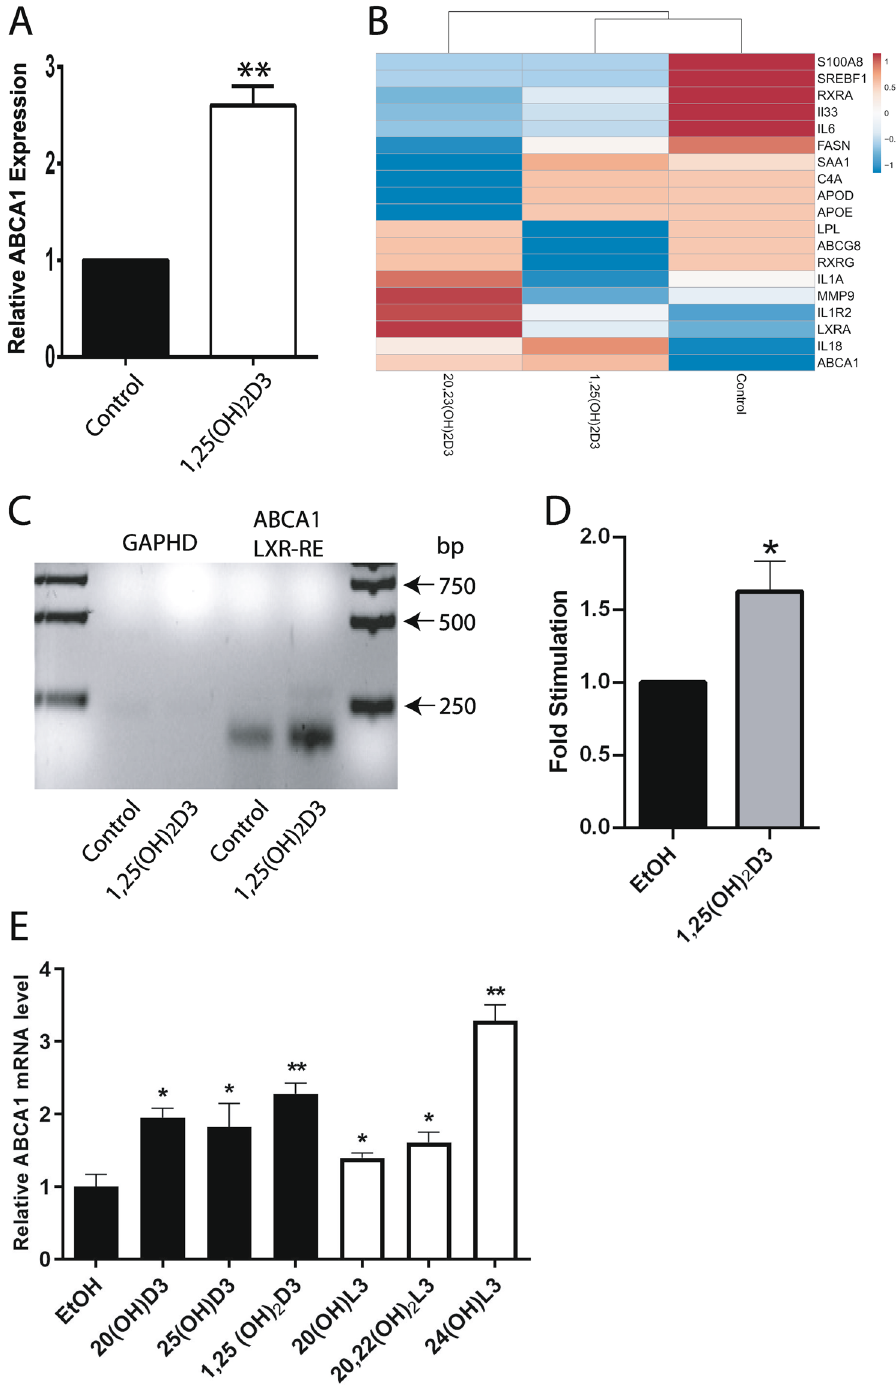
Figure 1. 1,25(OH) 2 D3 and CYP11A1-derived secosteroids stimulate LXR activated ABCA1 gene expression in HaCaT keratinocytes. Relative expression of ABCA1 gene after treatment with 10 –7 M 1,25(OH) 2 D3 and 20,23(OH) 2 D3 for 6 ( A ) and 24 h ( B ). Values were retrieved from microarray data deposited at the NCBI GEO (GSE117351) 44 . ChIP analysis performed on isolated nuclei from HaCaT keratinocytes treated with 1,25(OH) 2 D3 using antibody against both LXRα and β, showed significant stimulation of the LXRα/β binding to the LXR-RE of the ABCA1 ( C ) but not the control gene, GADPH . Means ± SD from 3 independent experiments ( D ). QPCR quantification of ABCA1 in RNA from HaCaT keratinocytes (n = 3) treated with 20(OH)D3, 25(OH) D3, 1,25(OH) 2 D3, 20(OH)L3, 20,22(OH) 2 L3 and 24(OH)L3 (E). *p < 0.5 and **p < 0.01 by student t-test. The experiment was repeated 3 times. The heatmap was prepared using ClustVis software (https:// biit. cs. ut. ee/ clust